Question: Give a one-sentence summary of this figure.
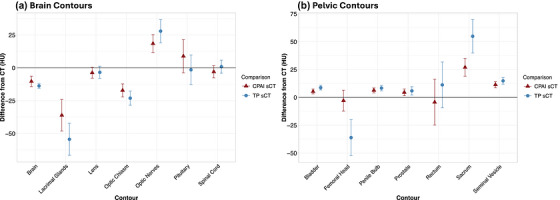
Answer: Mean Hounsfield unit difference for (a) brain contours and (b) pelvic contours between the reference CT and the sCT. The red triangle points indicate the mean HU difference between the CPAI contours on the sCT with the CPAI reference CT contours, and the blue circle indicates the mean difference between the TheraPanacea (TP) contours and the CPAI reference CT contours. A positive value indicates a greater TheraPanacea sCT value than reference CT value. Error bars indicate the standard error of the mean.